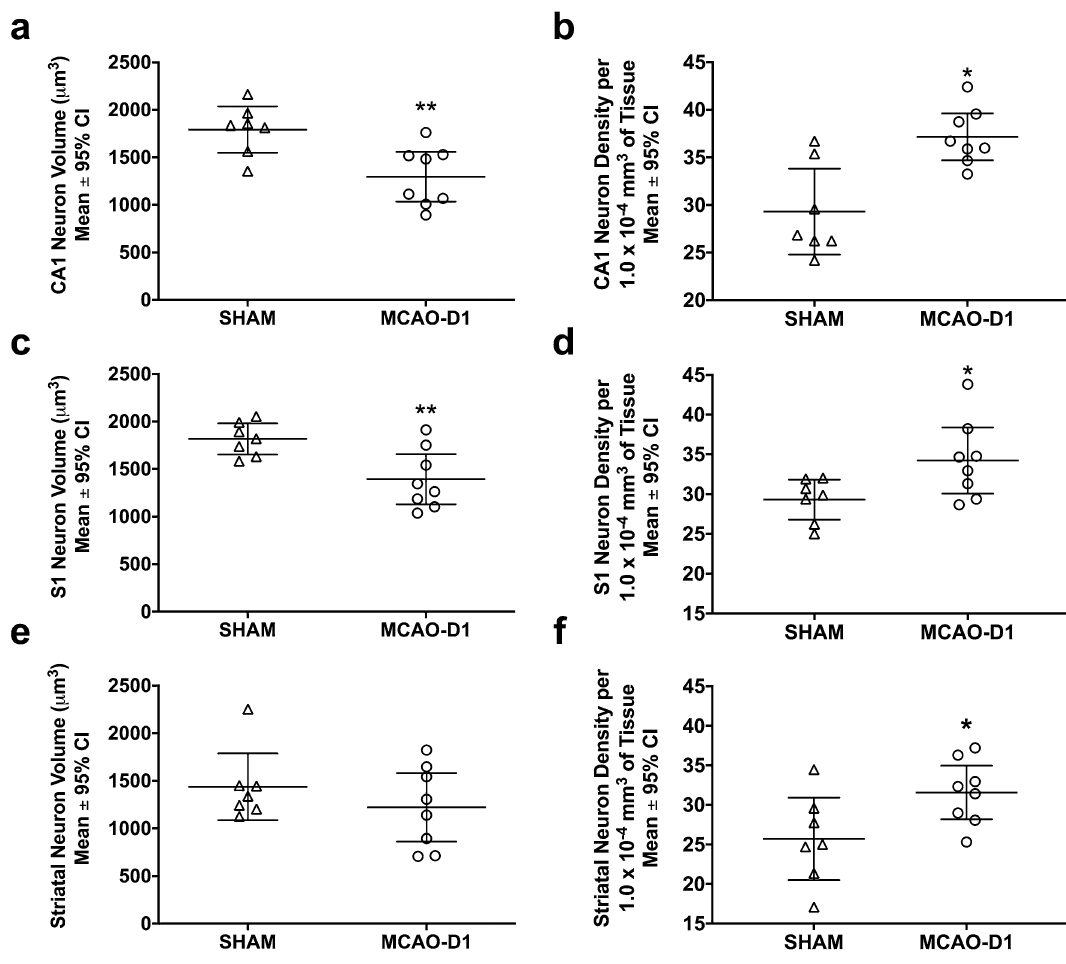
Figure 4. In experiment 2, contralateral neuron soma volume and density were analyzed 24 h following MCAO in CA1 ( a , b ), S1 ( c , d ), and the dorsal striatum ( e , f ). * p < 0.05 , ** p < 0.01 versus SHAMs. Scatterplots were made using GraphPad Prism version 8.4.3 for macOS, GraphPad Software, San Diego, California USA, www.graph